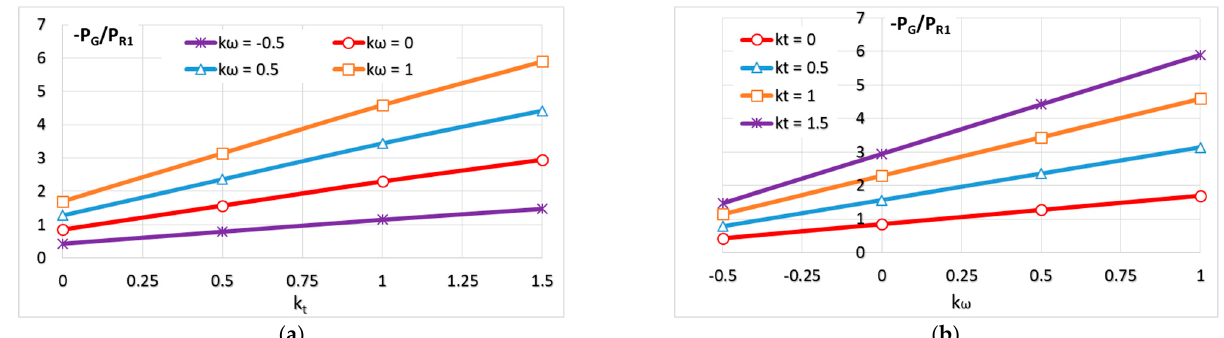
k ; ( b ) the k ; ( b ) the t k ; ( b ) the t t